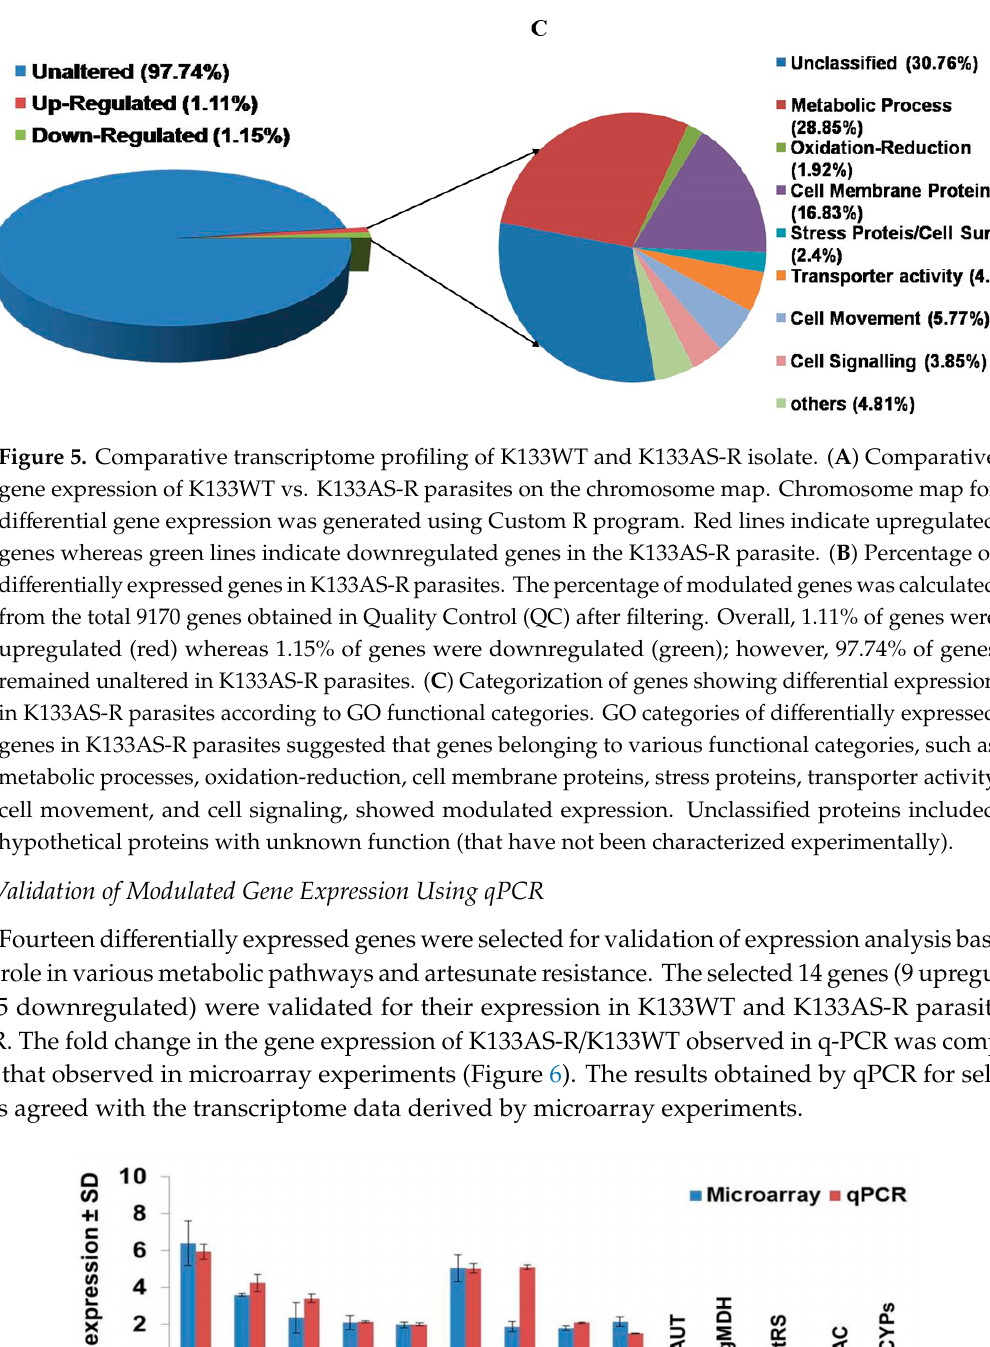
Figure 7. Expression analysis of AQP1 and HSP70 by Western blotting. Western blot analysis for the expression of AQP1 and HSP70 and α tubulin (endogenous control) protein was performed using 100 μ gpromastigote cell lysates of K133WT and K133AS-R parasites. Proteins separated on a 12% SDS–PAGE gel, transferred to nitrocellulose membranes that were probed with anti-AQP1, anti-HSP70, or anti- α tubulin antibody followed by horseradish peroxidase (HRP)-conjugated antibody and developed using enhanced chemiluminescence (ECL). 3.8. Susceptibility of K133WT and K133AS-R Parasites in the Presence of the AQP1 Inhibitor and Modulator of ABC Transporters The susceptibility of K133WT and K133AS-R parasites towards artesunate was determined in the presence of AQP1 inhibitor and modulator of ABC transporters, verapamil. The cytotoxicity of the AQP1 inhibitor or verapamil determined for host macrophages (mice PECs) by the MTT assay revealed that the cytotoxic concentration 50% (CC 50 ) of the AQP1 inhibitor was 233.47 ± 40.19 and that of verapamil was 111 ± 14.17 (Figure S2). The IC 50 of K133AS-R parasites towards artesunate significantly decreased by 1.9-fold in the presence of the AQP1 inhibitor and 2.2-fold in the presence